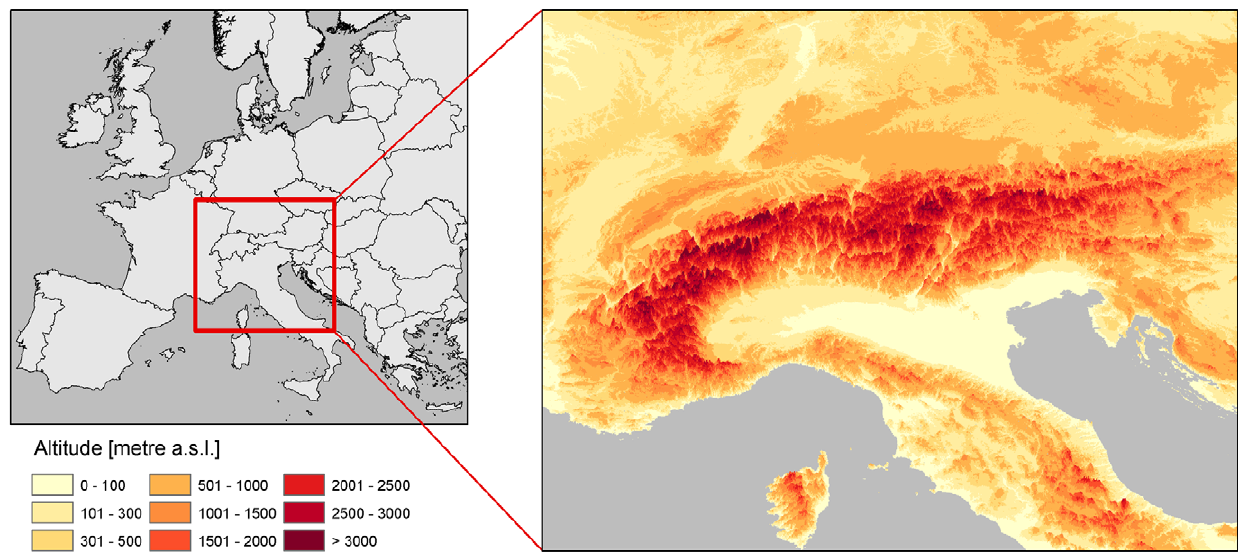
Figure 1. Location and topography of the Alps. Elevation is visualised in tenfold vertical exaggeration. The Alps are the highest mountain range in the continental interior of Europe separating the Mediterranean region from Central Europe and extending from France (West) through Switzerland and Italy (South) into Austria, Germany (North) Slovenia, and Croatia (East). Alpine regions are considered as the main natural barrier for natural sandfly